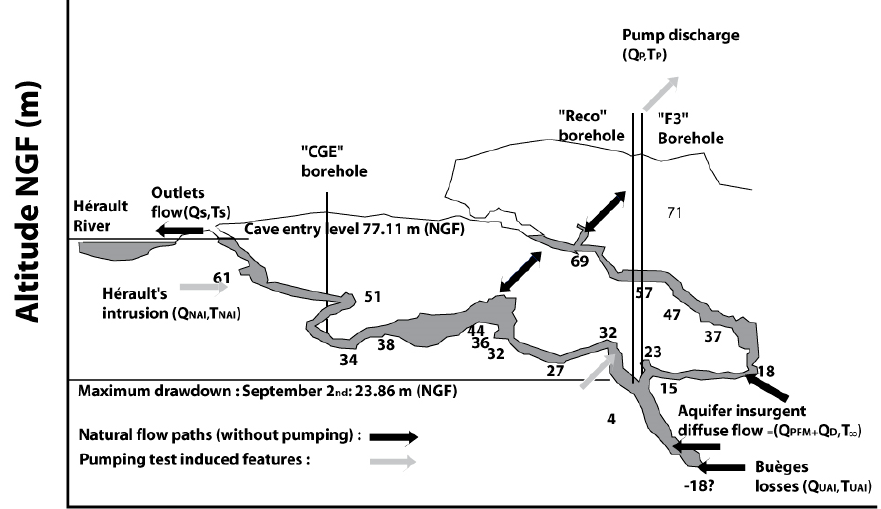
Figure 2. Unrolled 3-D speleological map of the Cent-Fonts CS near the resurgence. Altitudes are in m NGF (Nivellement Général de la France). Note the locations of the Cge, Reco and F3 boreholes.